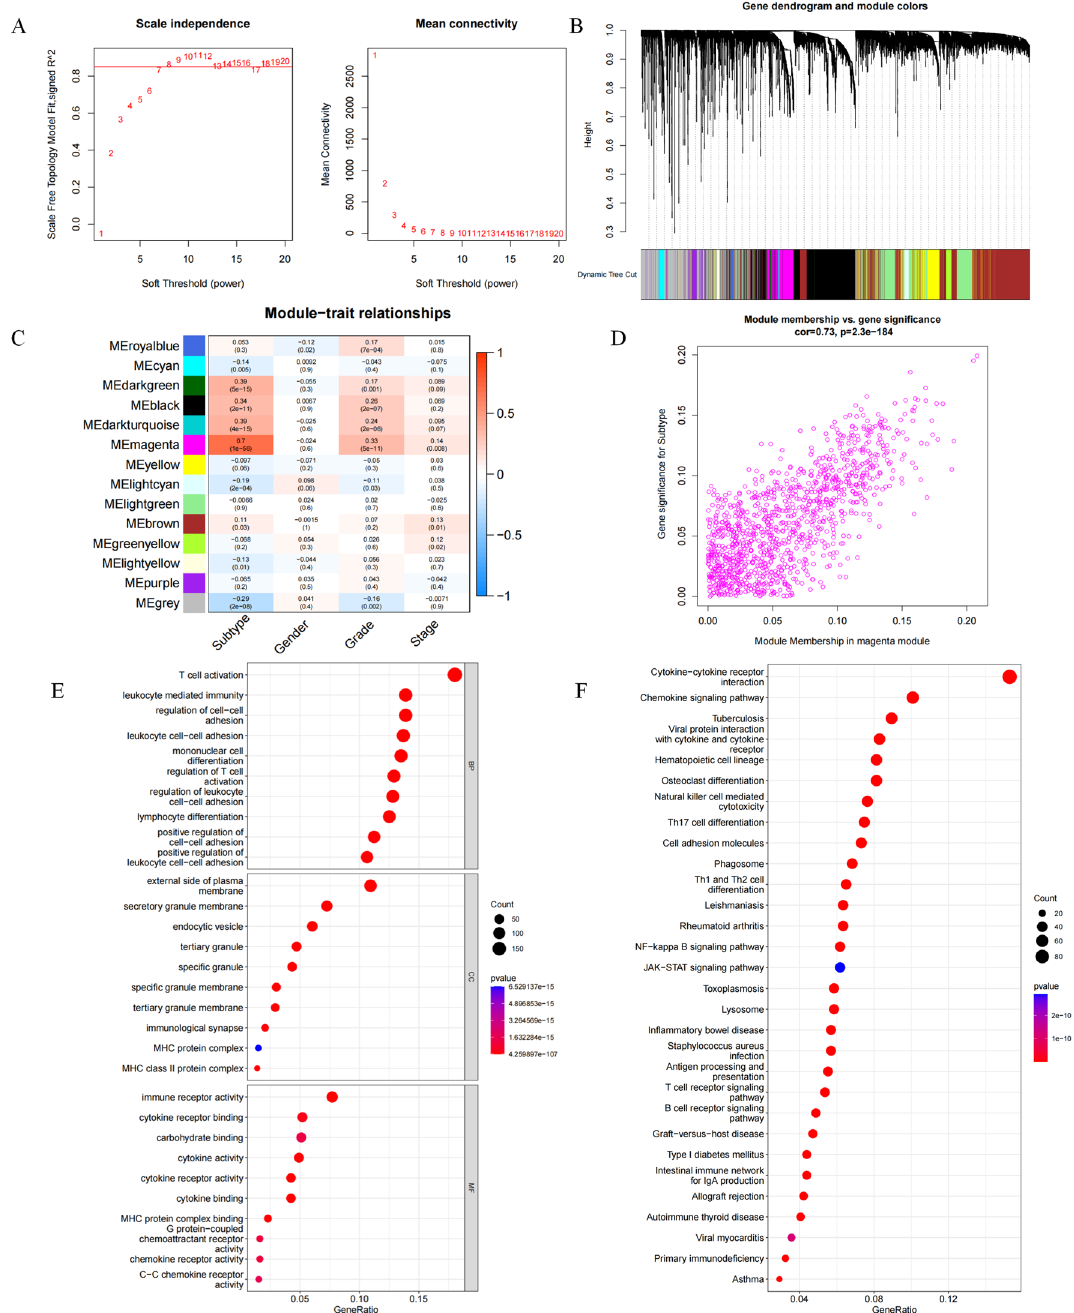
Figure 2. The weighted correlation network analysis. ( A ) Determination of soft thresholds. ( B ) Identification of gene clustering modules. ( C ) Correlation meter analysis between gene modules and phenotypes. Memagenta modules are highly correlated with subtypes ( D ) The correlation coefficient between gene significance (GS) and module membership (MM). ( E ) GO enrichment analysis. ( F ) KEGG enrichment